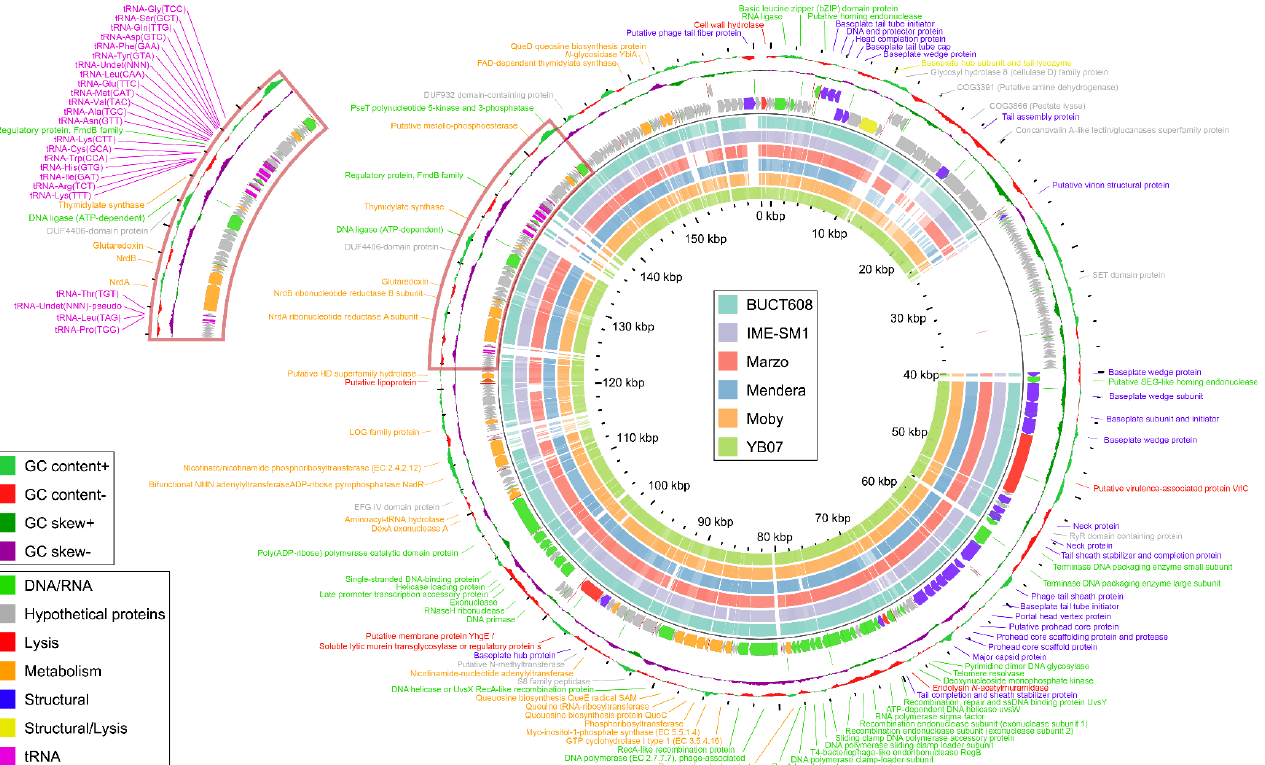
Figure 7. Genome map of Ps15. Outer line graphs depict the GC content and GC skew of the genome. The genome features are coloured based on the gene type, function of the encoded protein, or genomic feature. Inner coloured rings show high identity matches of other Menderavirus genomes against Ps15. The red box marks an area of tRNAs with a magnified image in the top left corner showing their position on the genome. Image generated with GView [57].